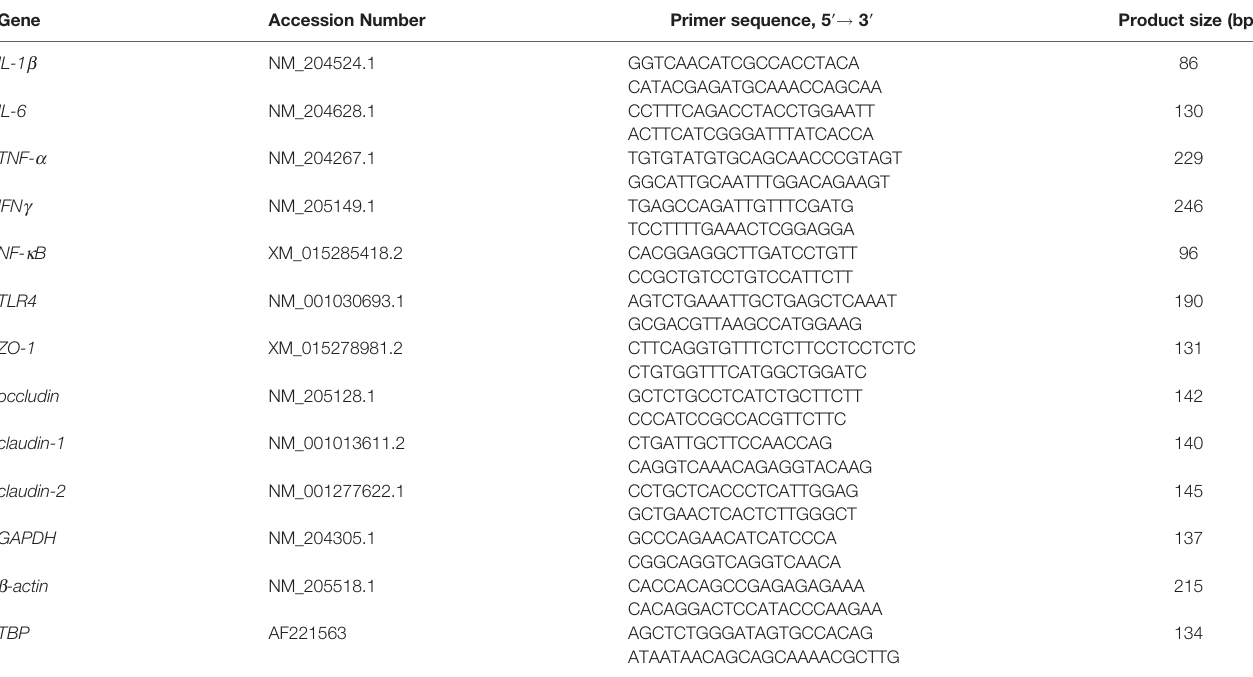
TABLE 2 | Nucleotide sequences for real-time PCR